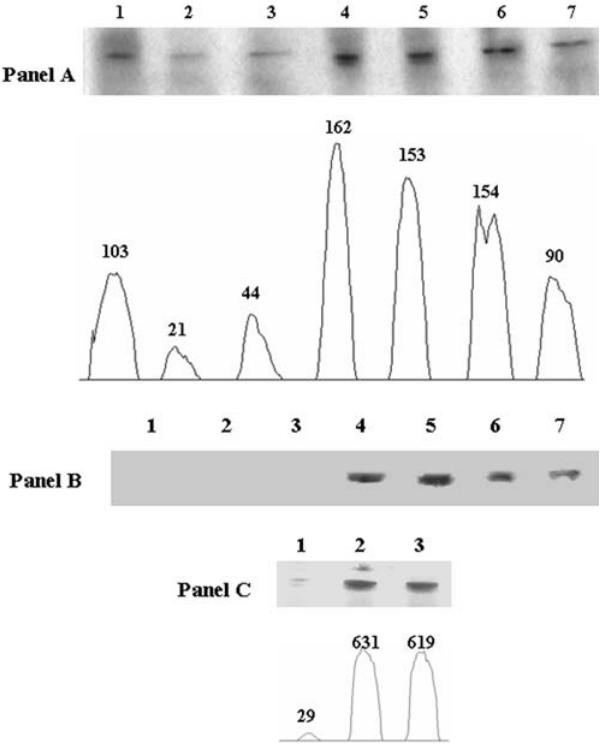
Figure 2. Panel A) In-gel detection of MDH in P. fluorescens grown in control and menadione- stress conditions. Lanes 1, 2, and 3 correspond to the membrane CFE from cells grown in control media for 15, 24, and 30 hrs. Lanes 4, 5, 6, and 7 correpond to the membrane CFE from cells grown in a menadione-stressed media for 25, 30, 35, and 40 hrs. Bands were quantified using SCION Imaging Software. Panel B ) In-gel detection of ME activity. Lanes 1, 2, and 3 correspond to soluble CFE from the cells grown in control medium for 25, 30, and 35 hrs. Lanes 4, 5, 6, and 7 correspond to soluble CFE from cells grown in menadione-stressed medium for 30, 35, 40, and 45 hrs. Panel C ) Regulation of ME activity. Lanes 1, 2, and 3 correspond to the soluble control CFE, soluble menadione-stress CFE, and soluble CFE from control cells transferred into a menadione-stress media. Bands were quantified using SCION Imaging Software. Cells were isolated at similar growth phases (25 h for control and 30 h for menadione) unless otherwise